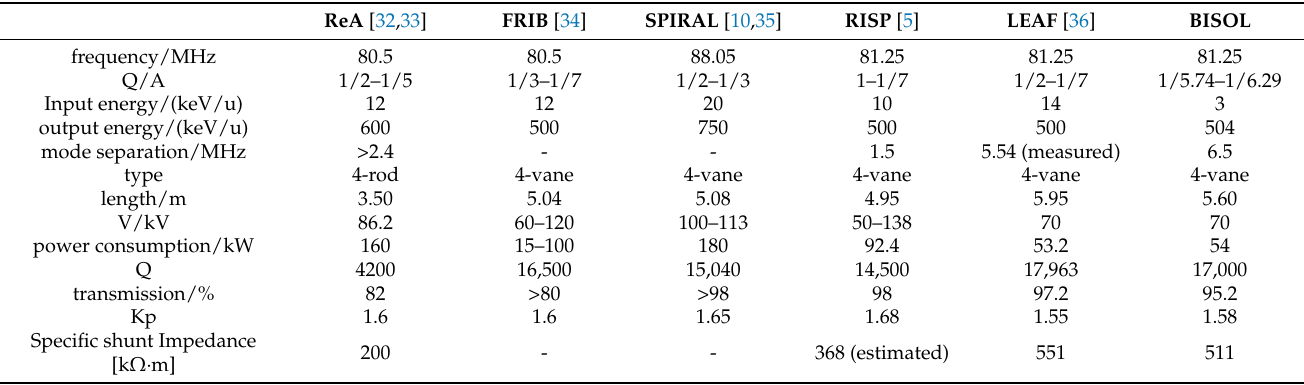
Table 8. Main parameters of International CW heavy-ion RFQs.